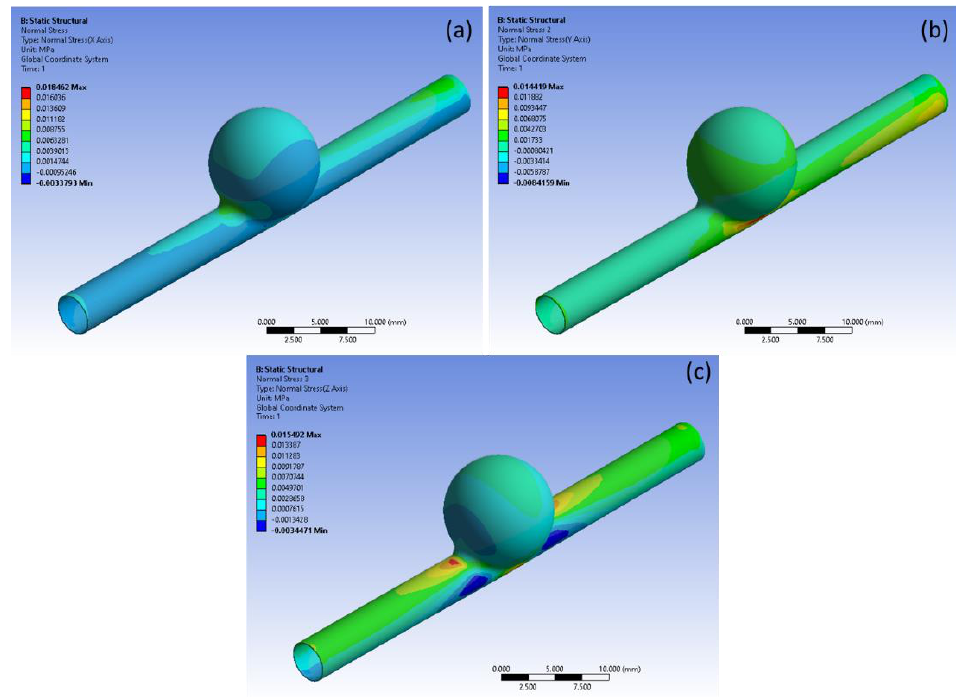
Figure 16. Normal Stress to Re = 1000. ( a ) X, ( b ) Y and ( c ) Z axis .